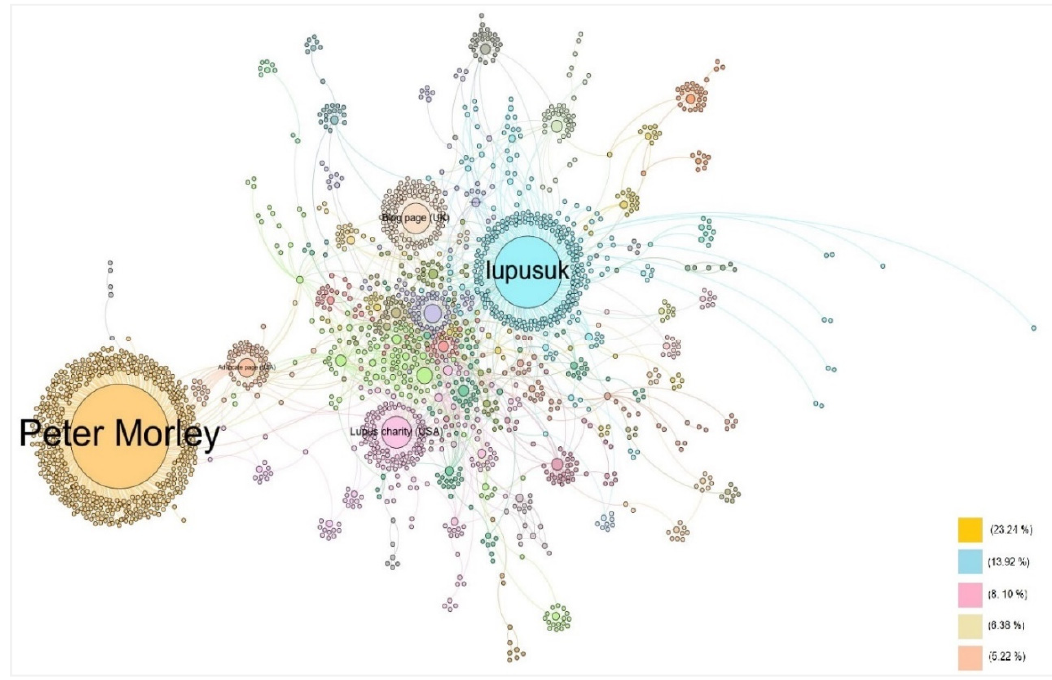
Figure 2. Retweet network analysis.